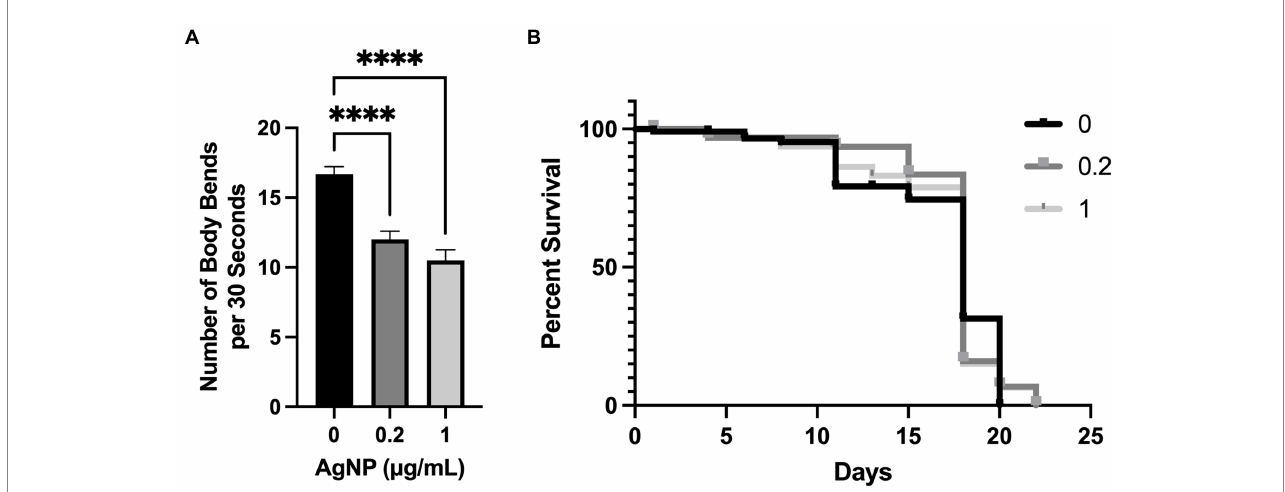
FIGURE 6 The effect of AgNPs on C. elegans motility and lifespan. (A) C. elegans motility was assessed in the presence of 0.2 and 1.0 μ g/mL of AgNPs and a non- treated control by measuring the number of body bends (thrashing) per 30 s in a total of 40 worms per each group. (B) C. elegans lifespan was assessed in non-treated control worms and in the presence of 0.2 and 1.0 μ g/mL of AgNPs using a total of 100 worms per group. Error bars represent SEM. Statistical significance was calculated using a one-way analysis of variance (ANOVA) followed by multiple comparison Dunnett’s post-hoc test (**** p < 0.0001) for motility and the Kaplan–Meier survival analysis for lifespan. The difference in lifespan between the control and 0.2 and 1.0 μ g/mL AgNPs was non- significant.